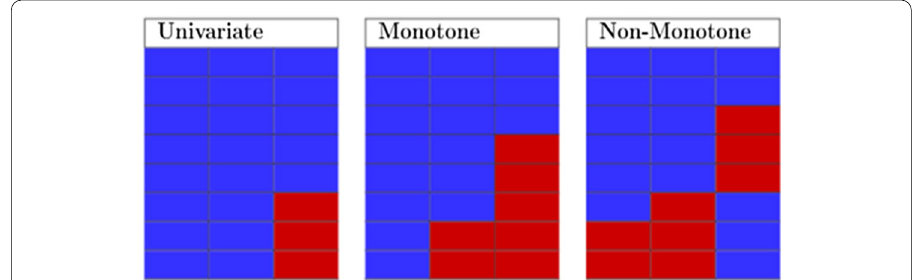
Fig. 1 Representation of missing data patterns data. Blue represents observed values; red is missing